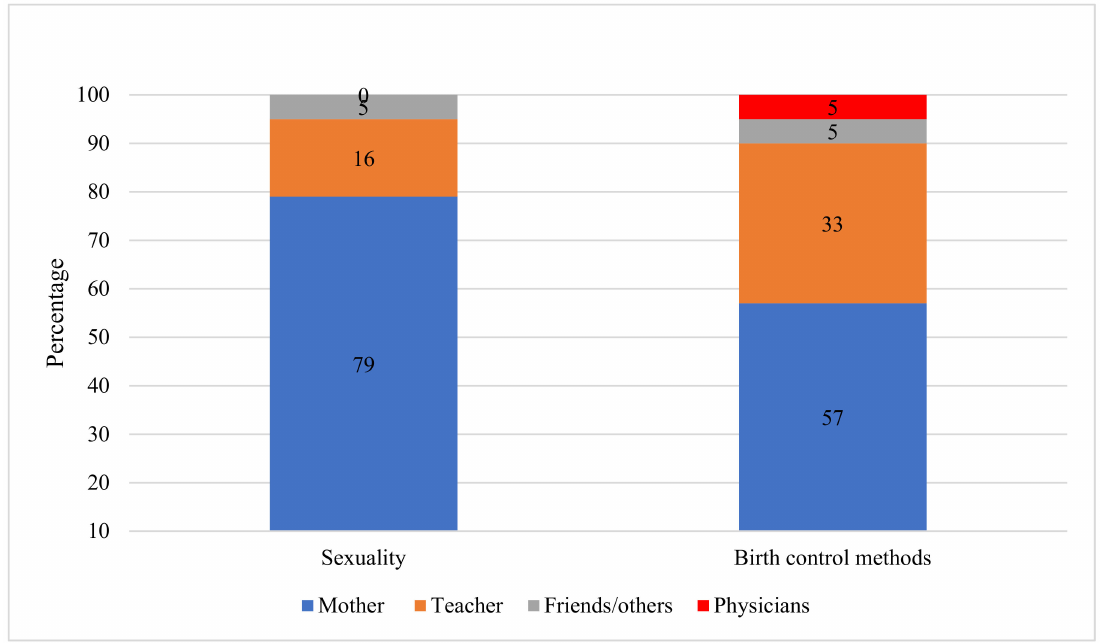
Figure 1. Sources of information about sexuality and birth control methods in a sample of pregnant